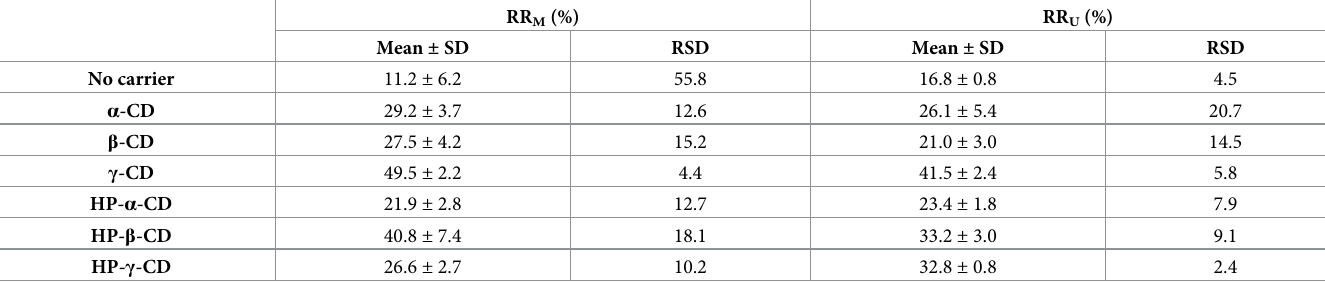
Table 1. RR M and RR U of doxorubicin when using different types of cyclodextrin as